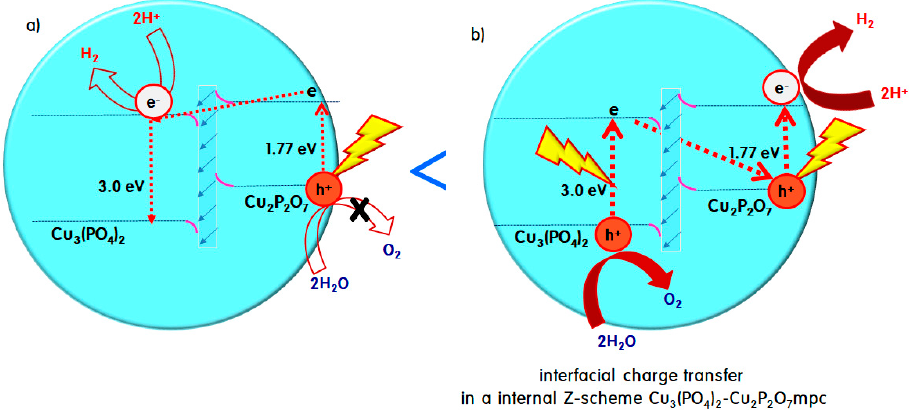
Figure 9. Overview on preparation process of the M 3 (PO 4 ) 2 -M 2 P 2 O 7 mpc (M = Co, Ni, and